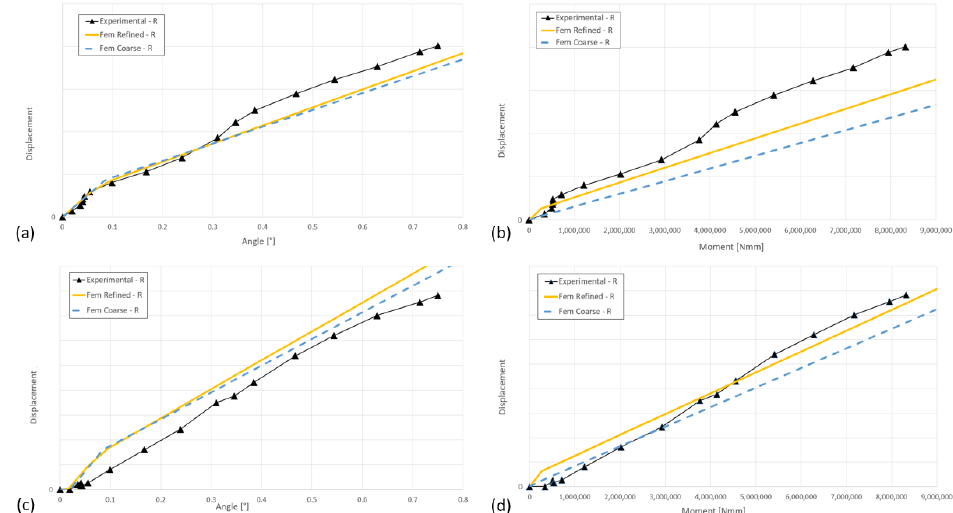
Figure 15. Comparison between experimental and FE displacement in the concentrated bending: ( a ) Measured at laser position, as a function of the rotation angle; ( b ) measured at laser position, as a function of the moment; ( c ) measured at cable position, as a function of the rotation angle; ( d ) measured at cable position, as a function of the moment.